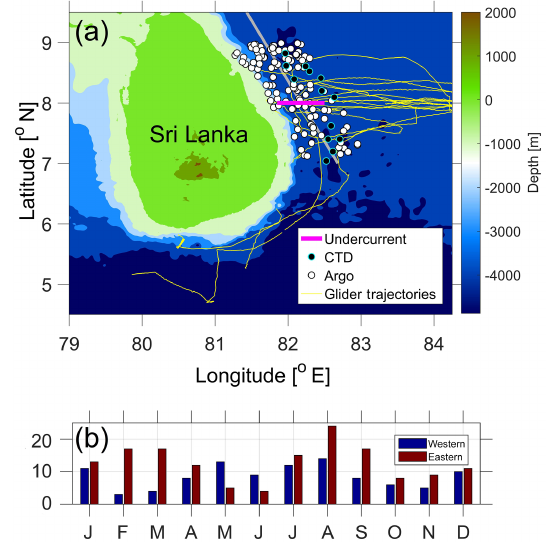
Figure 1. Bathymetry around Sri Lanka (a) with the location of the shipboard hydrography measurements (black dots), Argo profiles (white dots), and glider measurement transects (yellow lines). The grey line divides hydrography and Argo measurements into the east- ern and western sectors used in the seasonal mean dynamic height calculation. The OGCM outputs are interpolated along 8 ◦ N (ma- genta line). The number of hydrography and Argo profiles available in the mean dynamic height calculation for each month for the east- ern (red) and western (blue) sectors are shown in (b)